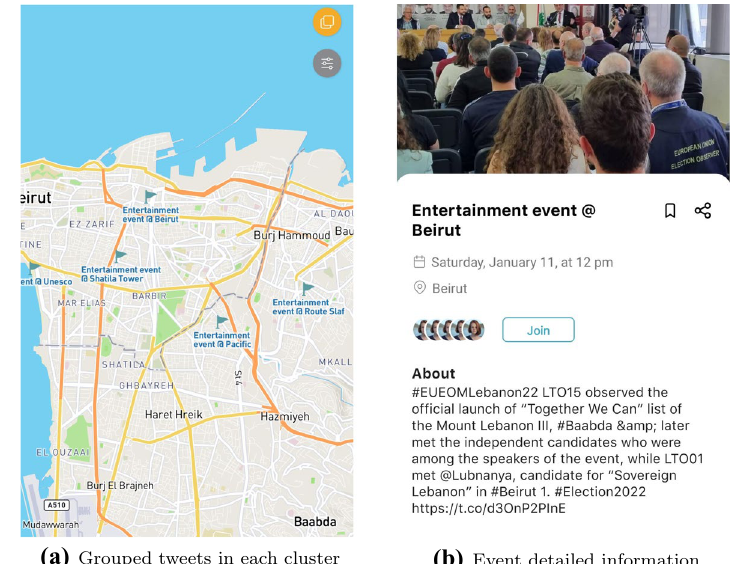
(a) Grouped tweets in each cluster (b) Event detailed information Fig. 8 Details from extracted